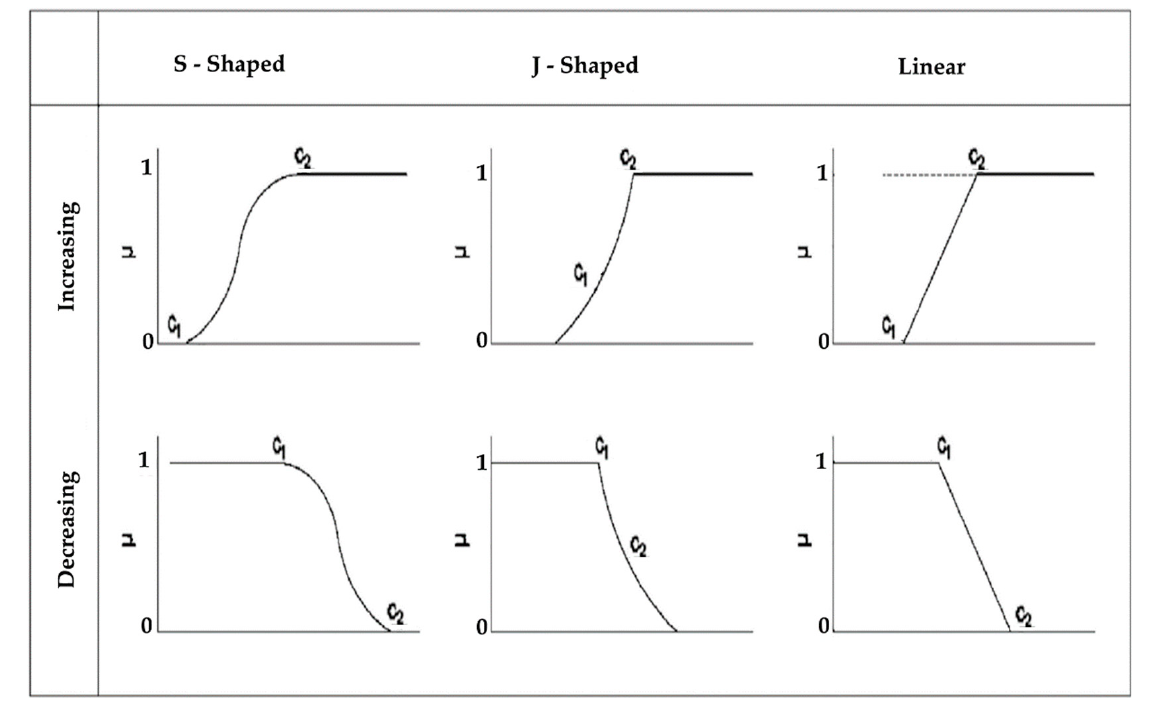
Figure 6. Fuzzy membership functions for factor standardization.